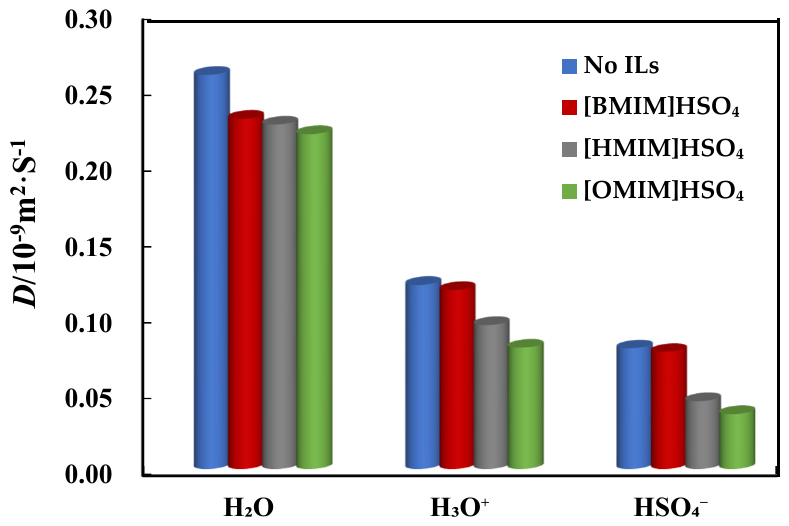
Figure 9. The diffusion coefficient of corrosive particles with addition of three ILs inhibitors from the MD. The number density is used to describe the density distribution of different corrosive particles from one point to the Cu(111) in the vertical direction. Figure 10 displays the number density distribution of the corrosive particles (H 2 O, H 3 O + , and HSO 4 − ) with or without the addition of three ILs molecules.